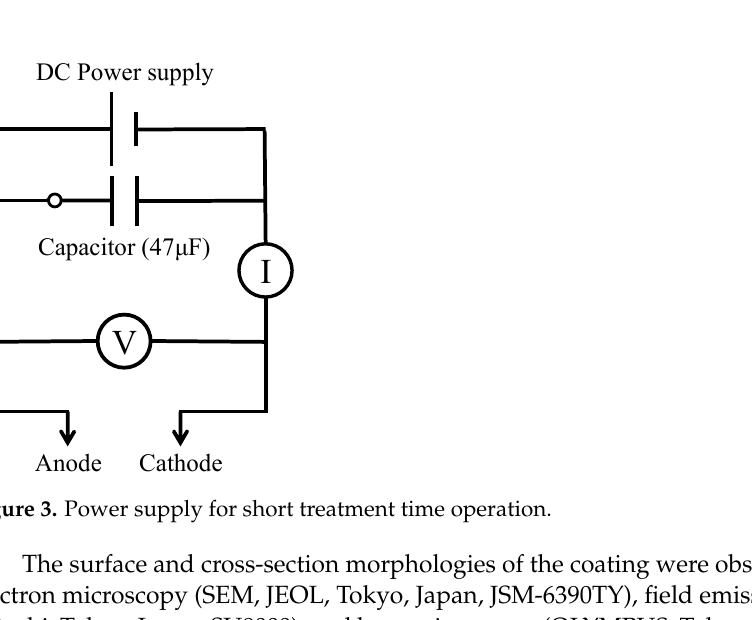
4 of 16 Table 1. Operating conditions of the PEO process. Operation